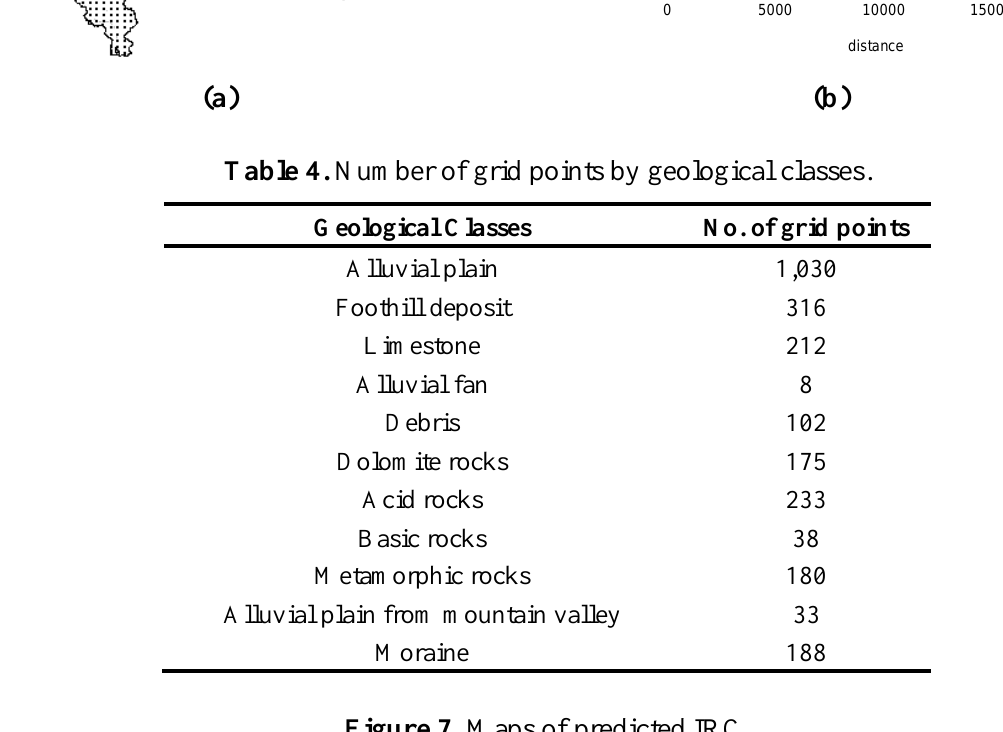
Figure 7. Maps of predicted